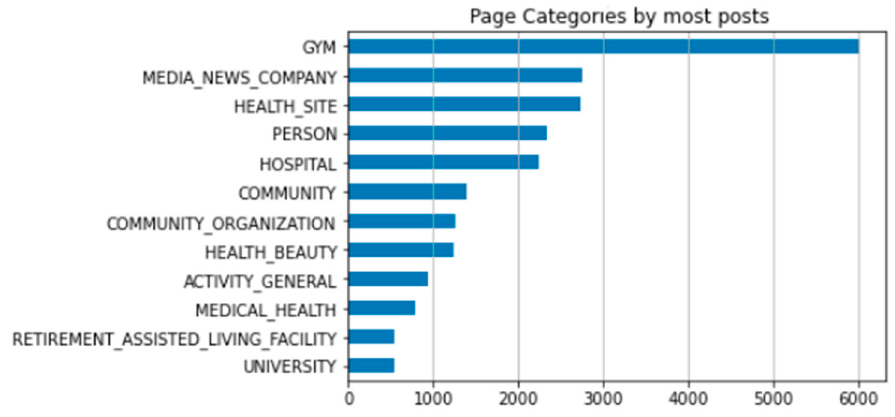
Figure 9. Graphical representation of most posts per page category.